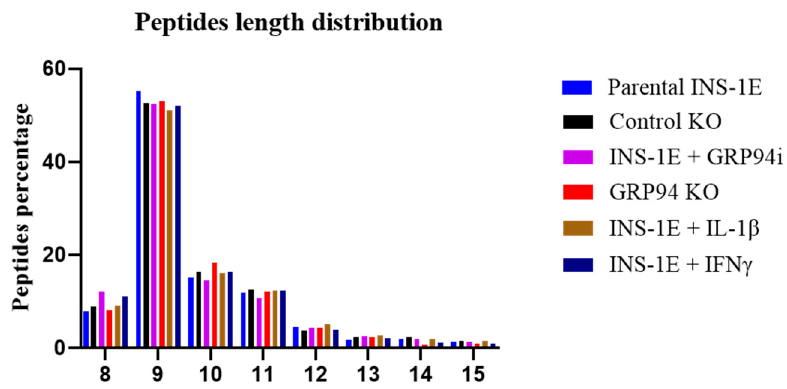
Figure 4. Length distribution for 8–15 amino acid-length peptides between parental INS-1E, control and confirmed GRP94 KO INS-1E, 24 h treatment with GRP94 inhibitor (20 µM), or INS-1E cells exposed to cytokines IL-1 β (15 pg/mL) or IFN γ (10 ng/mL). n = 2 for all except GRP94 KO where n = 4.